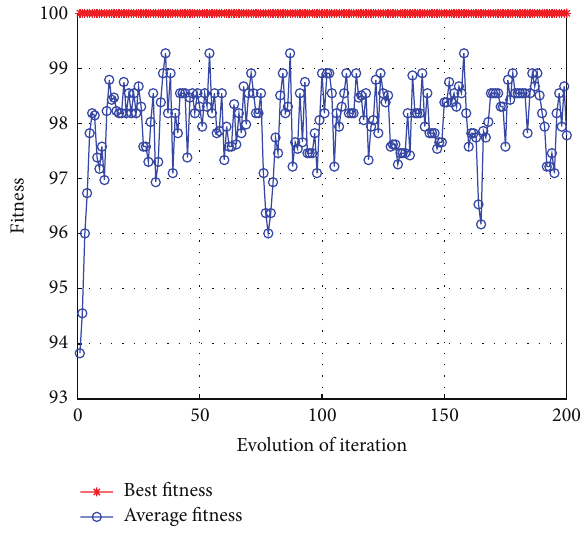
Figure 5: The fitness curve of searching for the best parameters by the SPSO method. Table 1: Performance comparison.